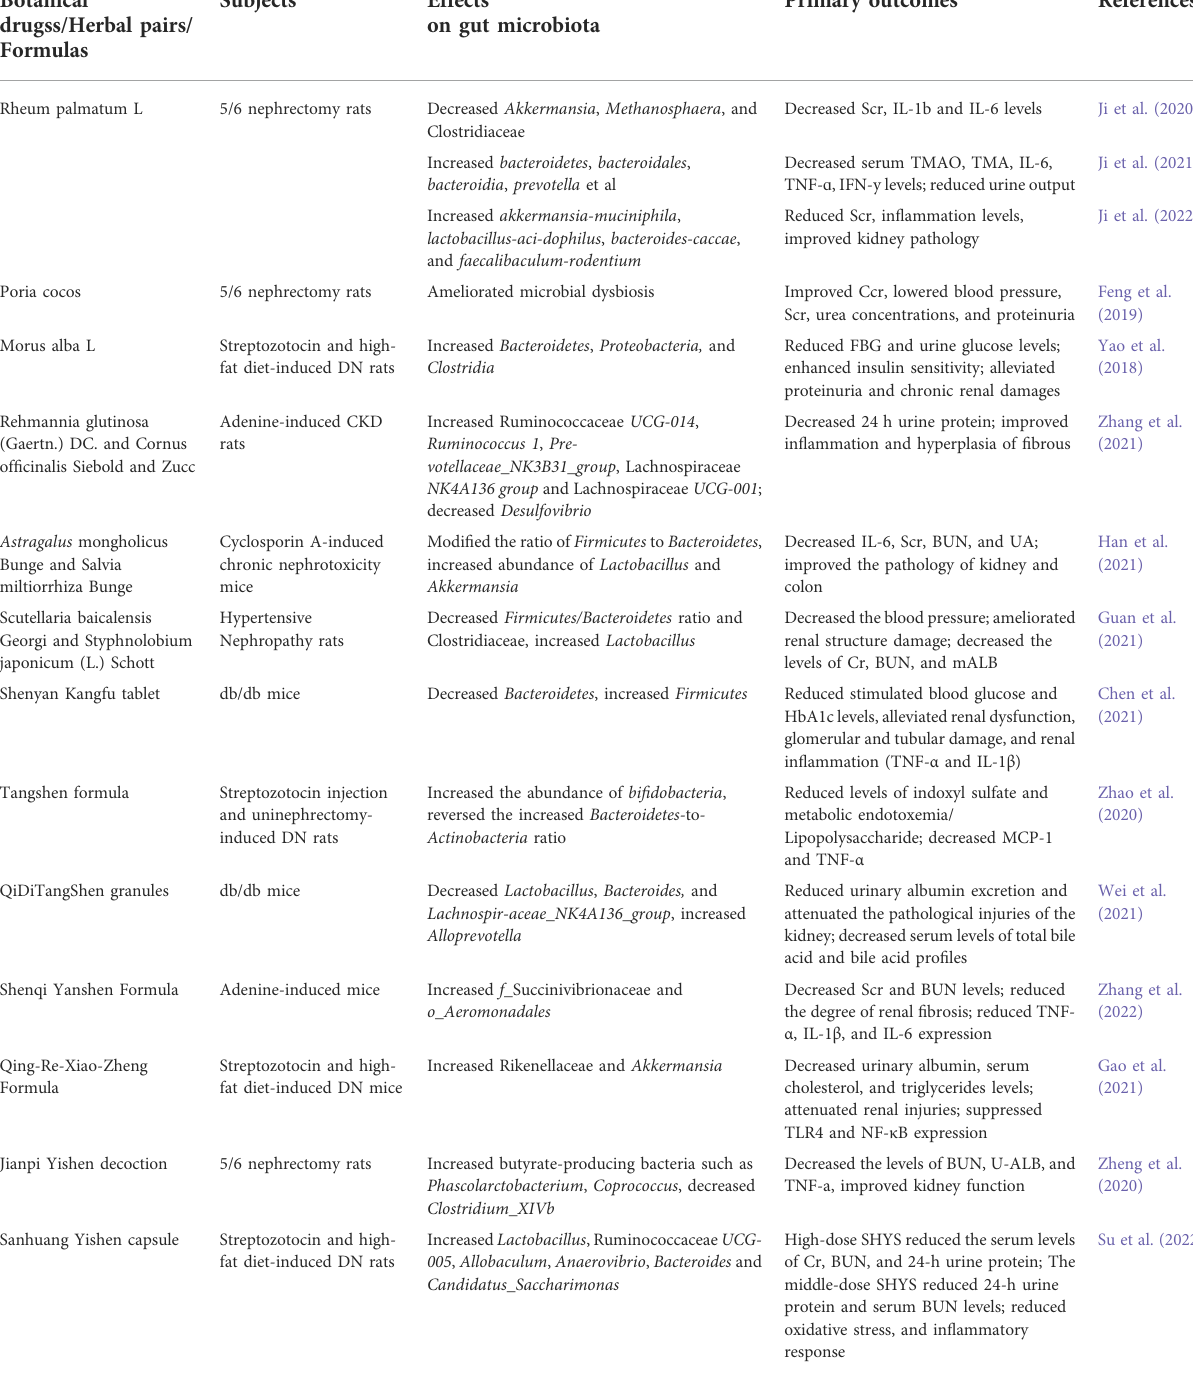
TABLE 1 Summary of the effects of herbal medicine on gut microbiota and laboratory